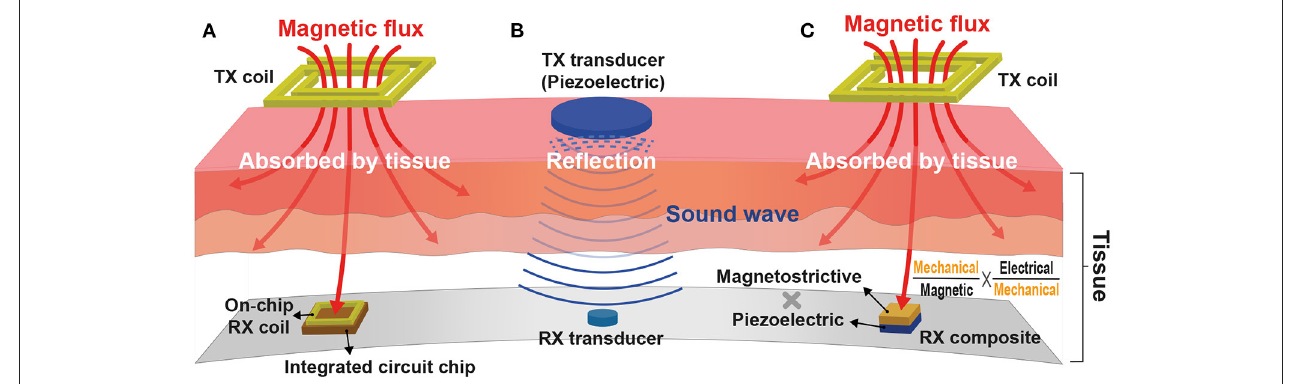
FIGURE 12 | Wireless power transfer (WPT) modalities for a miniaturized implant: (A) Inductive WPT using an on-chip power receiving coil; (B) Ultrasonic WPT having a short wavelength; and (C) Magnetoelectric WPT integrating both inductive and ultrasound